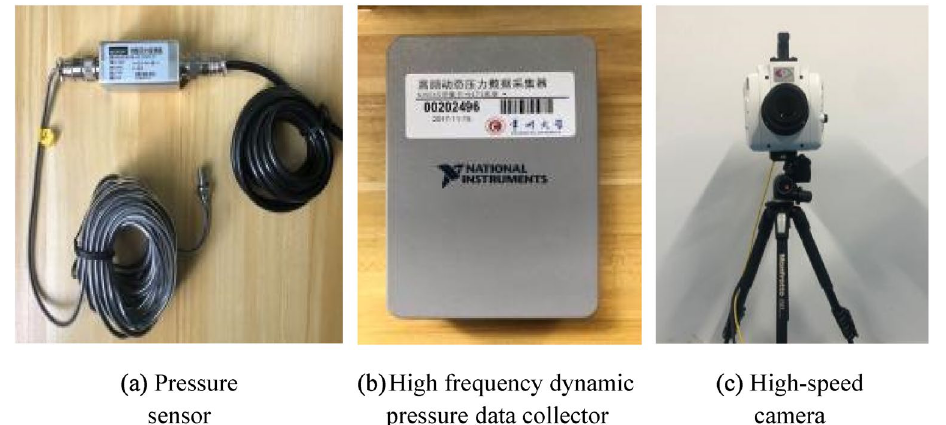
Figure 3. Experimental facilities ( a ) pressure sensor, ( b ) high frequency dynamic pressure data collector, ( c ) high-speed camera.